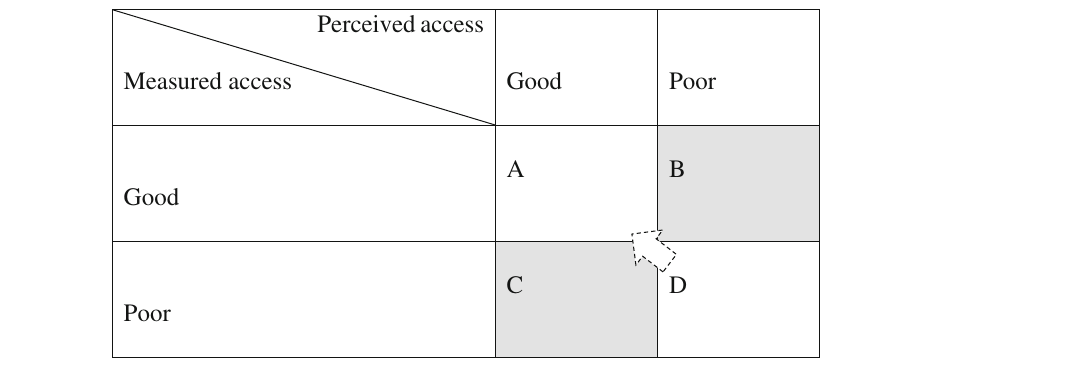
Table 1 Possible outcomes of perceived and measured